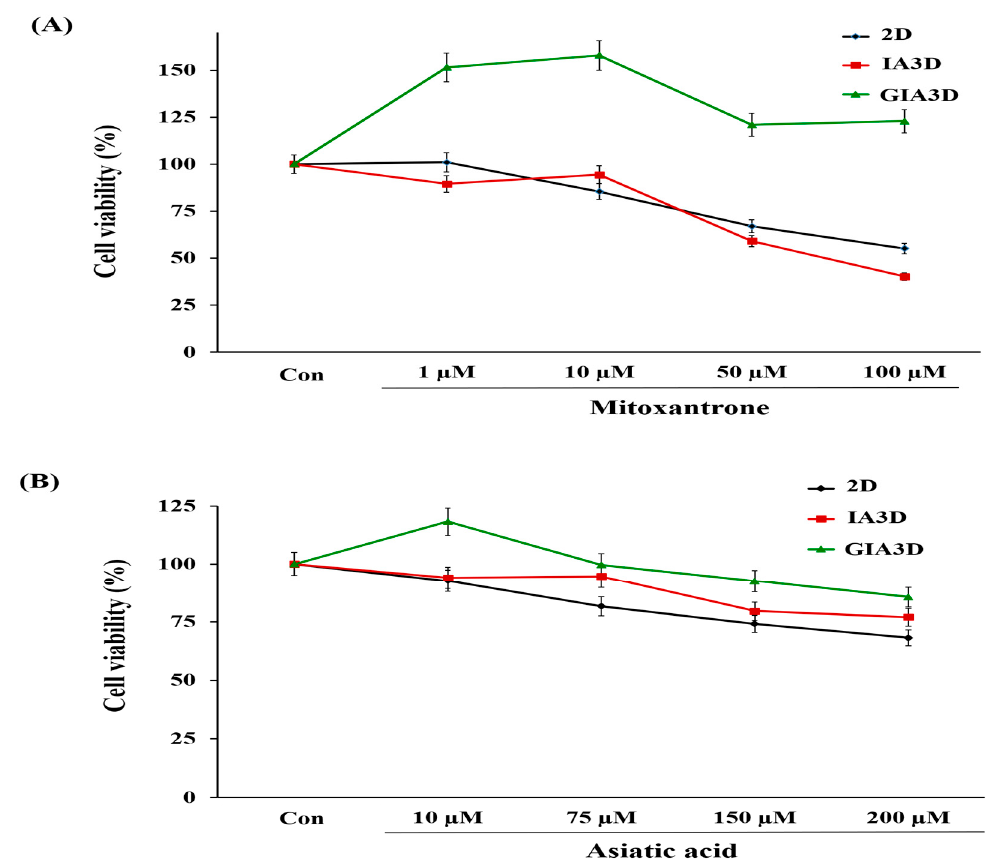
Figure 9. Cytotoxic effects of drugs on HepG2 cells. ( A, B ) Effects of mitoxantrone and asiatic acid drugs on HepG2 cells cultured in two-dimensional culture, industrial acrylonitrile butadiene styrene, and gold nanoparticle-coated ABS scaffold. The cells were seeded at 3 × 10 3 cell/mL, incubated for 72 h afterward, and treated with mitoxantrone (1–100 µM) or asiatic acid (10–200 µM) for 24 h. The relative cell viabilities were calculated as the percentage of untreated cells. Results are expressed as mean ± SD, n = 3.